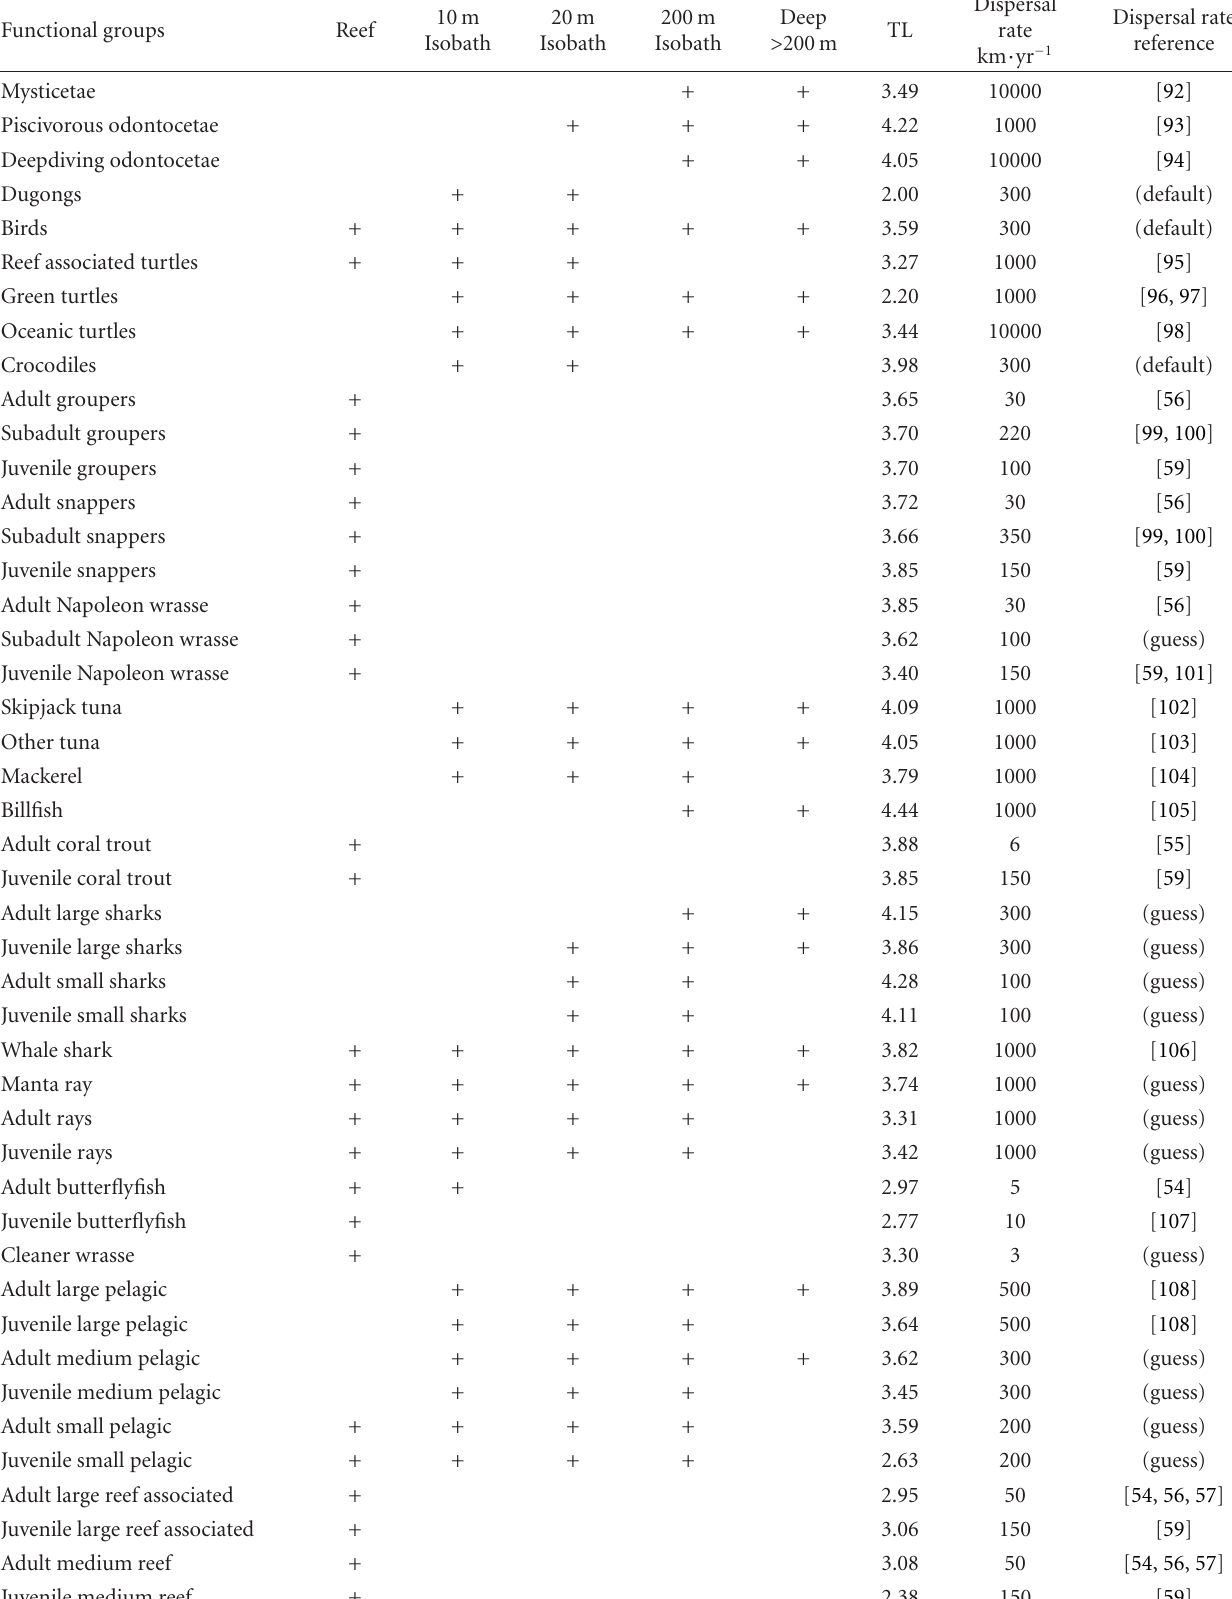
Table 2: Functional groups, habitat specifications, and dispersal rates in Raja Ampat Ecospace model. Functional